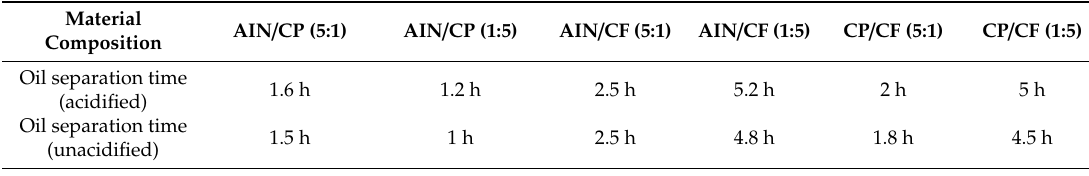
Table 2. Oil separation time of di ff erent components of thermal grease.